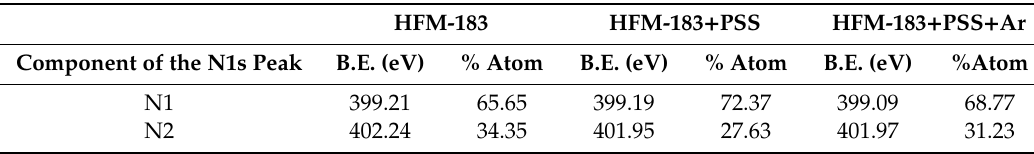
Table 6. Deconvolution of the N1s peak. HFM-183 HFM-183 + PSS HFM-183 + PSS + Ar Component of the N1s